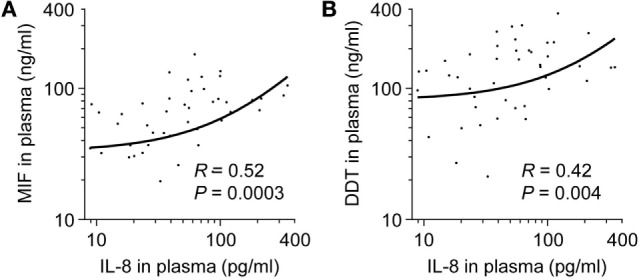
Comparison of macrophage migration inhibitory factor (MIF) and d-dopachrome tautomerase (DDT) to IL-8 plasma concentrations in very preterm newborns. Scatterplot comparing MIF (A) and DDT (B) to IL-8 plasma concentrations in paired measurements from 50 very preterm newborns. The regression lines are shown.